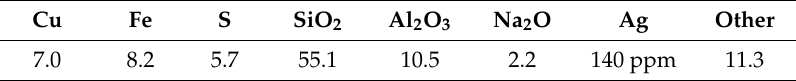
Table 1. Chemical composition of initial low-grade copper–silver concentrate, wt.